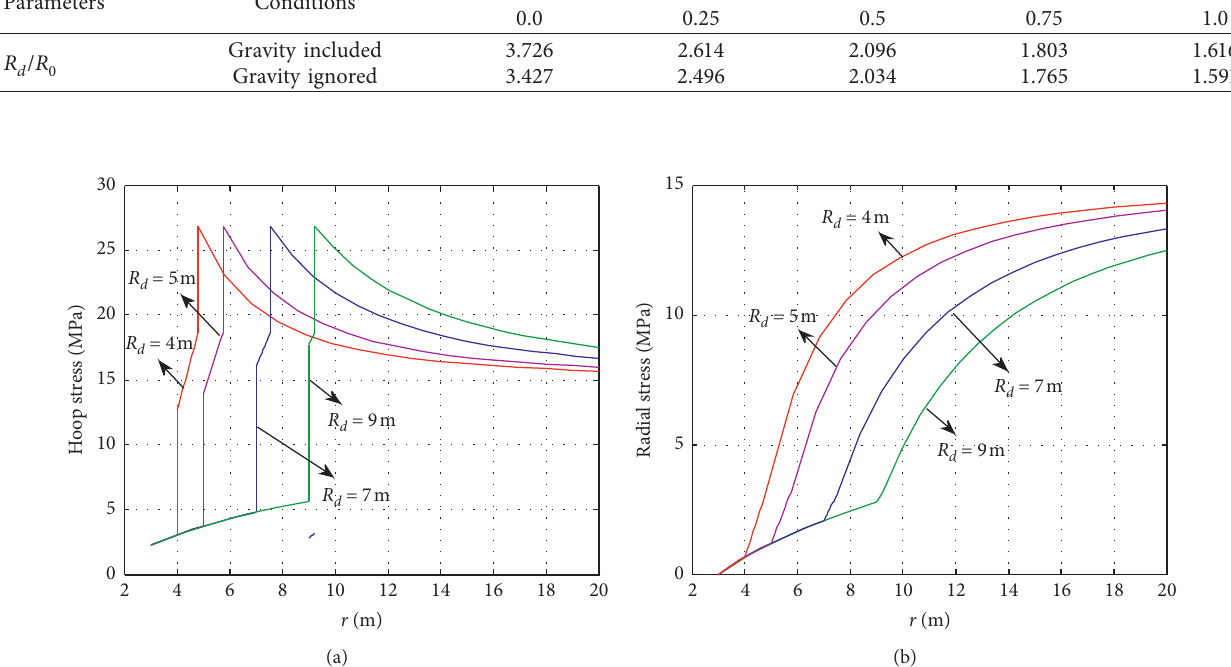
Figure 7: Hoop stress and radial stress of tunnel under various damage ranges ( c � 0 and b � 0). (a) Hoop stress. (b) Radial stress.